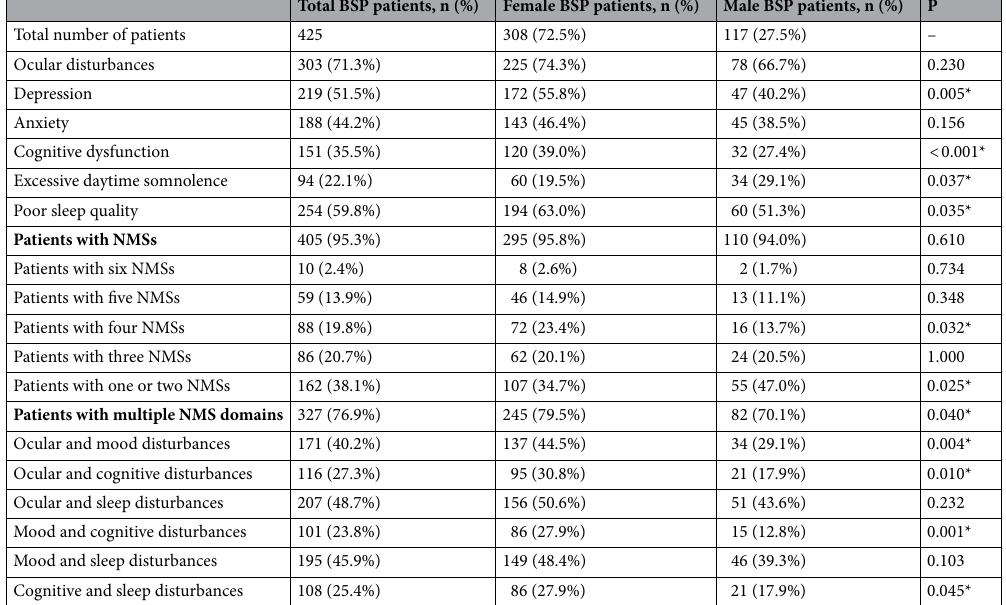
Table 2. Prevalence of NMSs and coexistence of NMS domains in 425 BSP patients. NMSs, nonmotor symptoms. *Significant difference.